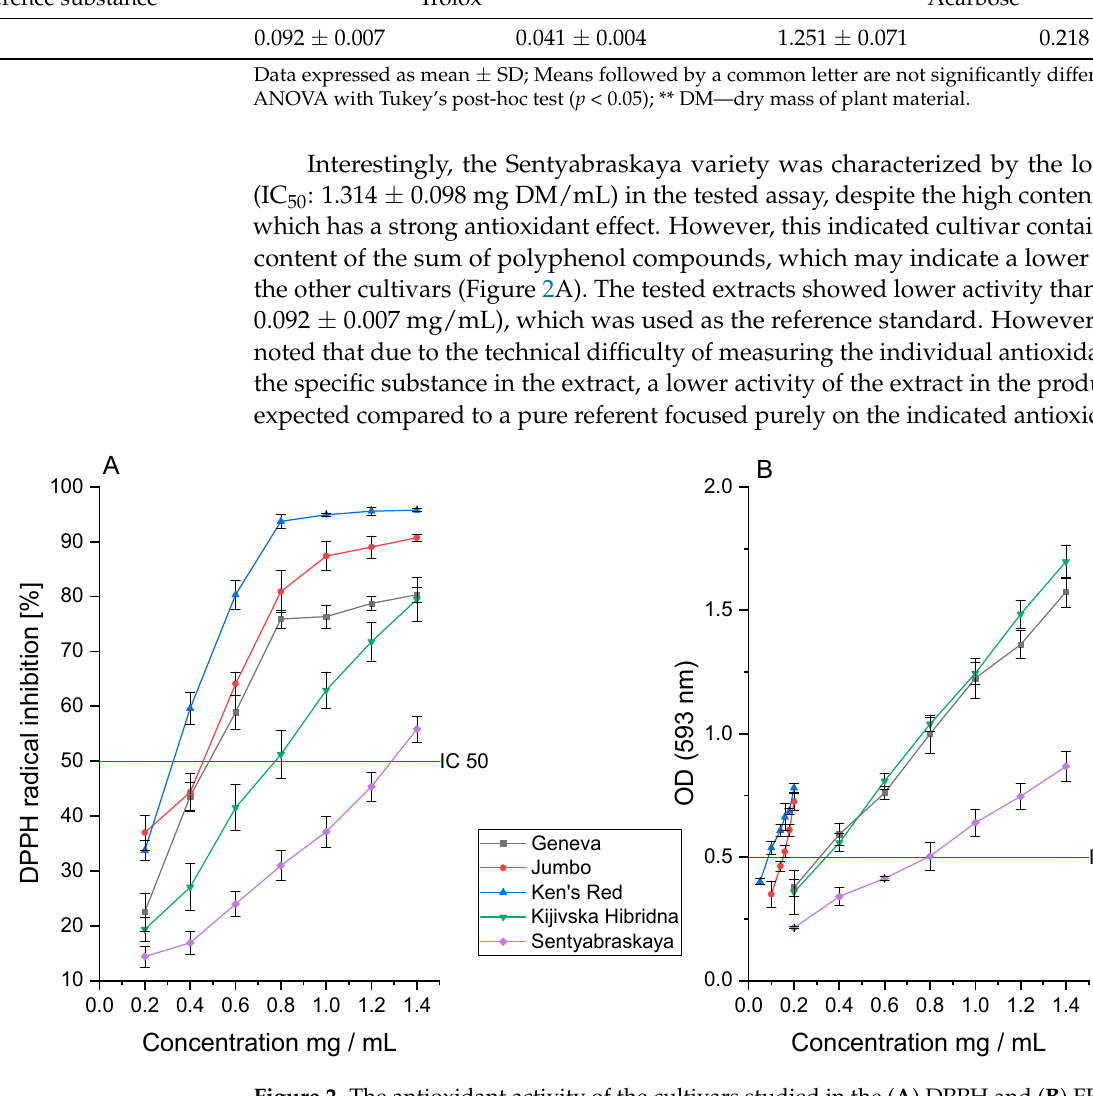
Figure 2. The antioxidant activity of the cultivars studied in the ( A ) DPPH and ( B ) FRAP assay. A similar analysis was carried out in the FRAP assay, confirming Ken’s Red’s highest activity (IC 0.5 : 0.064 ± 0.005 mg DM/mL). However, here, we did not observe a similar activity of the Jumbo (IC 0.5 : 0.149 ± 0.012 mg DM/mL) and Geneva (IC 0.5 : 0.320 ± 0.009 mg DM/mL) cultivars; significantly higher activity of the Jumbo cultivar was observed, similar to the Ken’s Red cultivar (Figure 2B). On the other hand, the Geneva variety was characterized by lower activity, this time similar to the Kijivska Hibridna variety (IC 0.5 : 0.333 ± 0.023 mg DM/mL). Here, we found a correlation between TPC and the activity studied,